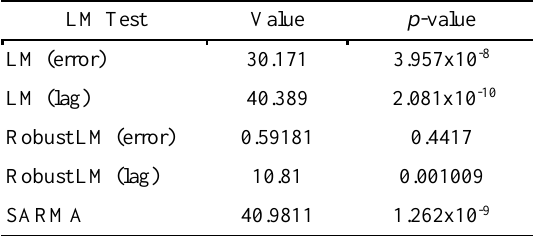
Table 2. Diagnostics for spatial dependence.